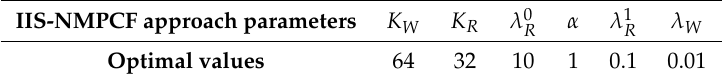
Table 2. The optimal parameters of the proposed method that obtain the best wheezing audio quality evaluating the dataset